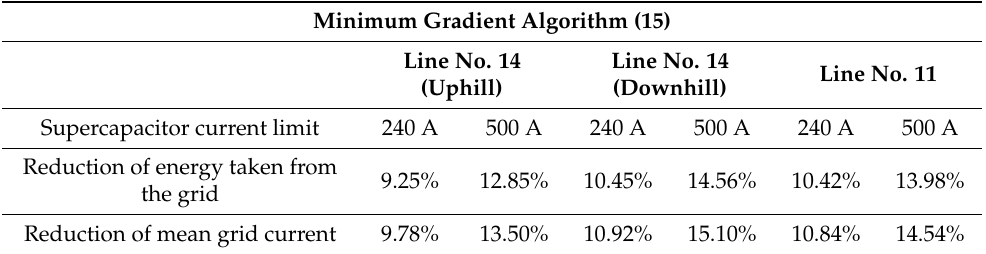
Table 6. Power grid energy saving and current grid reduction using the minimum gradient